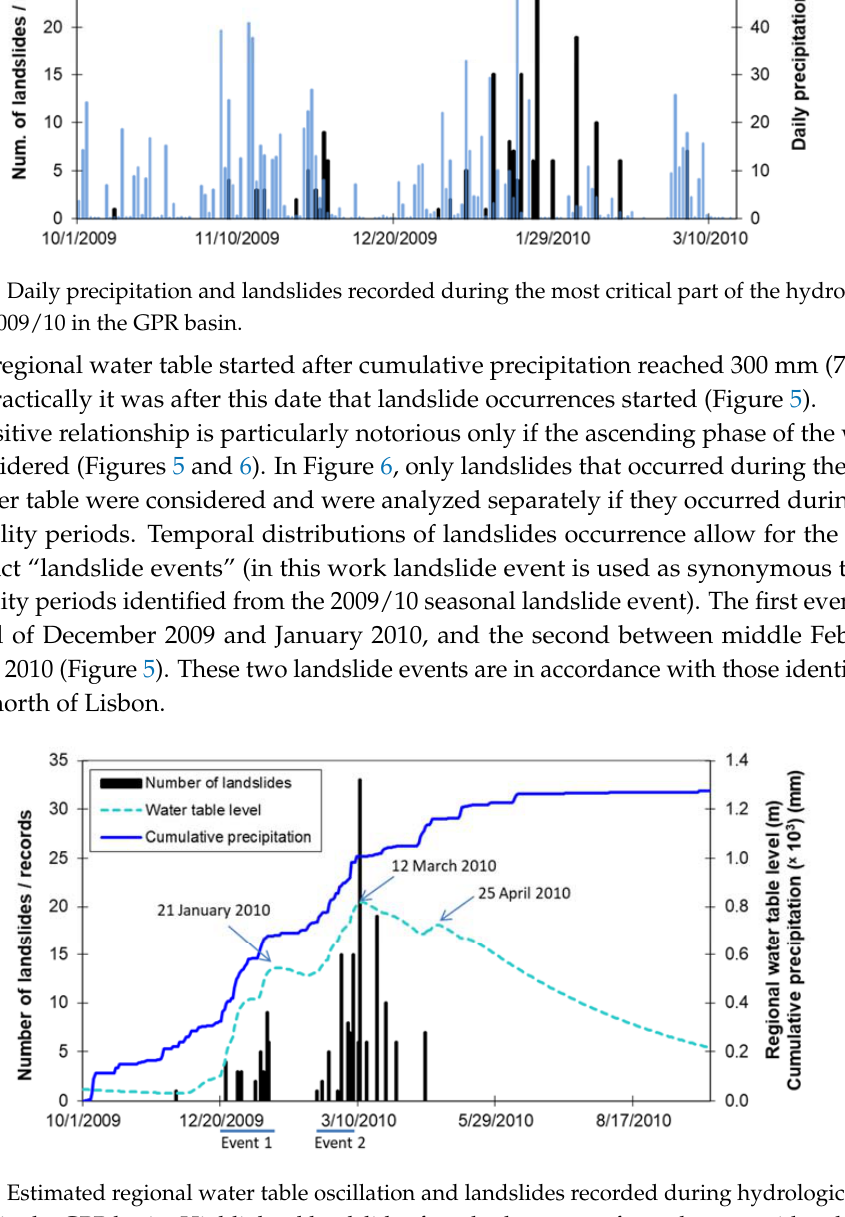
Figure 5. Estimated regional water table oscillation and landslides recorded during hydrological year 2009/10 in the GPR basin. Highlighted landslides from both events refer to those considered on the analysis done in Figure 6—those that occurred during rising phases of water table.